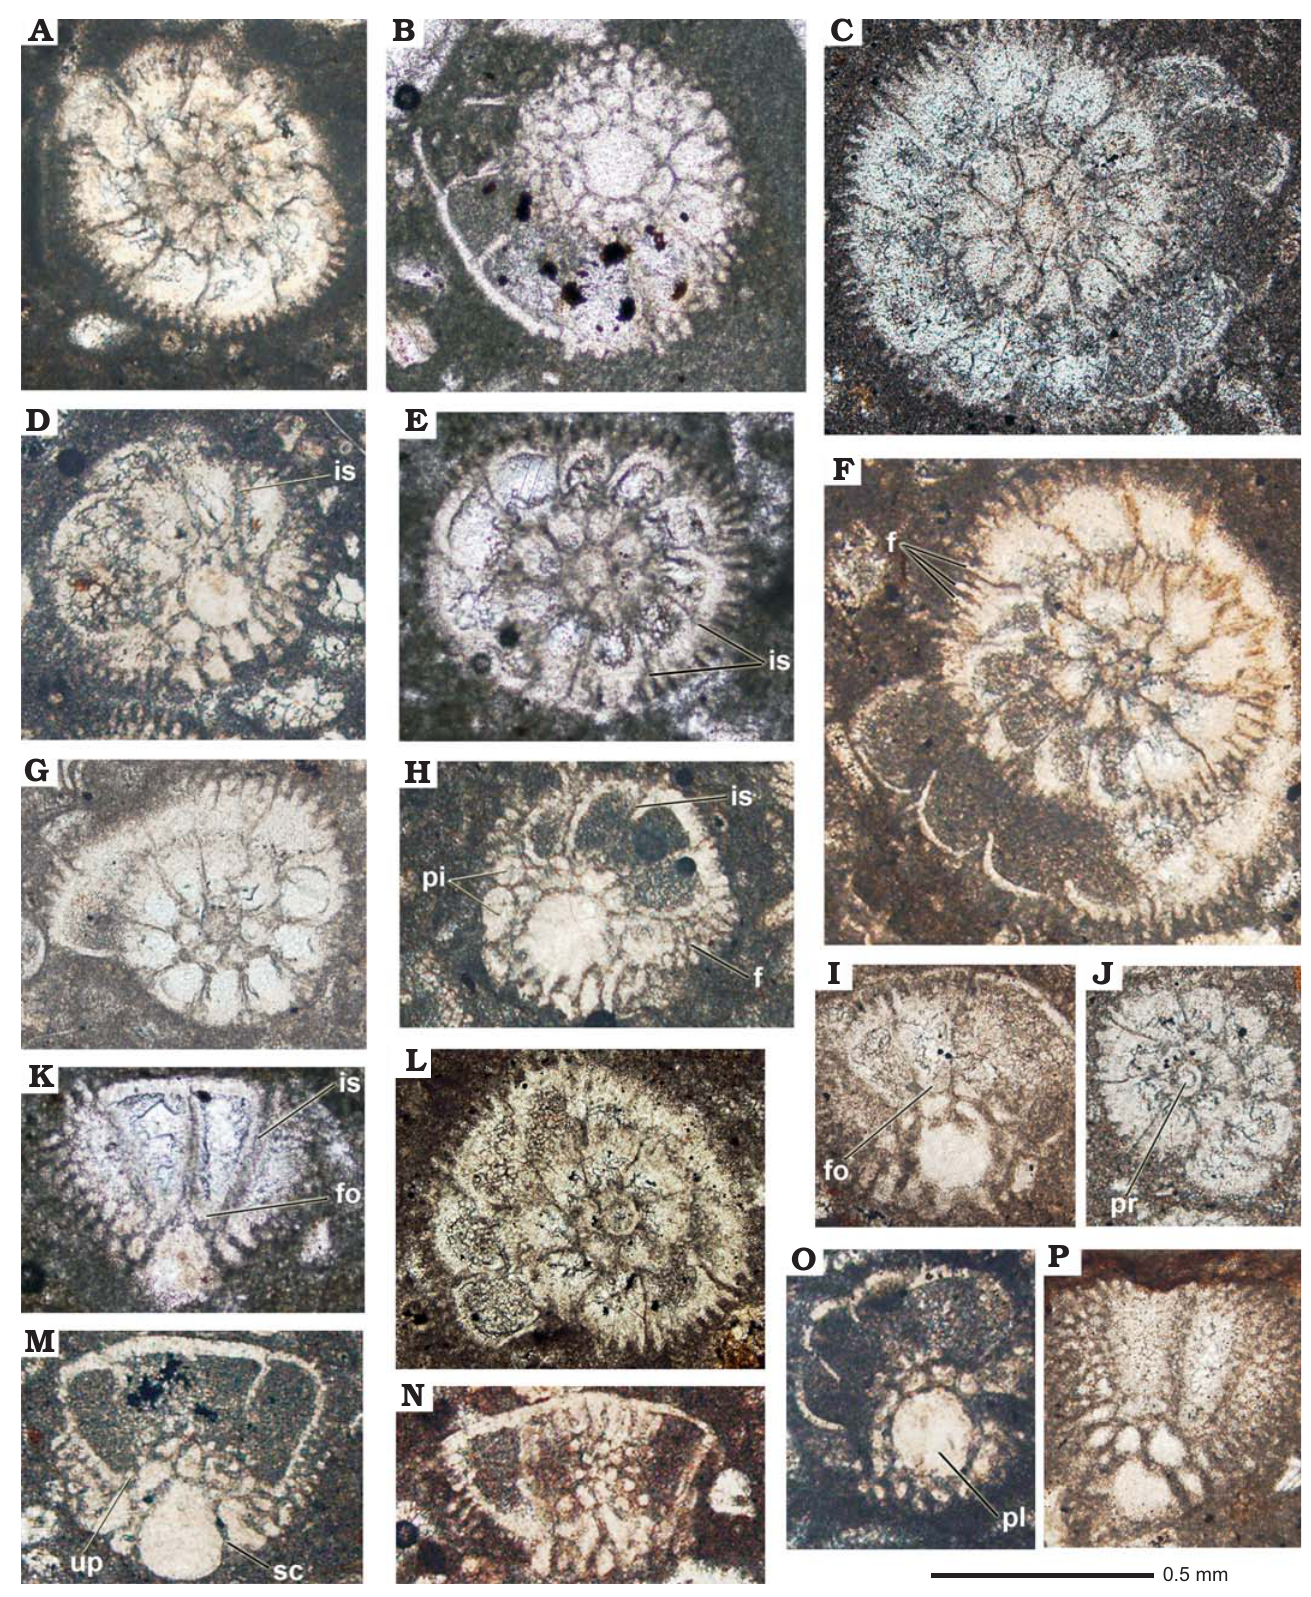
Fig. 5. Rotaliid foraminifer Elazigina siderea sp. nov. from the Tarbur Formation of Rod Abad (A, C, D, F–J) and Mandegan (B, E, K) sections, Iran; trans versal (A, C, E, J), transversal-basal (B, O), transversal-oblique (D, F–I, L), and tangential (K, M, N, P) sections. C , J , L , M . APNU-Tf12 (type- level). D , G – I , P . APNU-Tf11. A , N . APNU-Tf10. F . APNU-Tf14. O . APNU-Tf4. B , E . APNU-Rt53. K . APNU-Rt55. Abbreviations: f, feathers; fo, folia; is, intraseptal canals; pi, piles; pl, umbilical plug; pr, proloculus; up, umbilical plate; sc, spiral